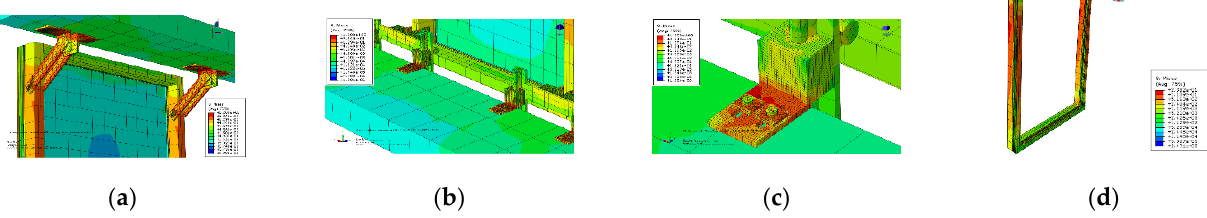
Figure 25. Stress distribution in each member of seismic curtain wall during Z -axis drift: ( a ) upper fastener-to-rigid beam connection part; ( b ) lower fastener-to-rigid beam connection part; ( c ) fastener-to-bolt connection part; ( d ) external aluminum frame.